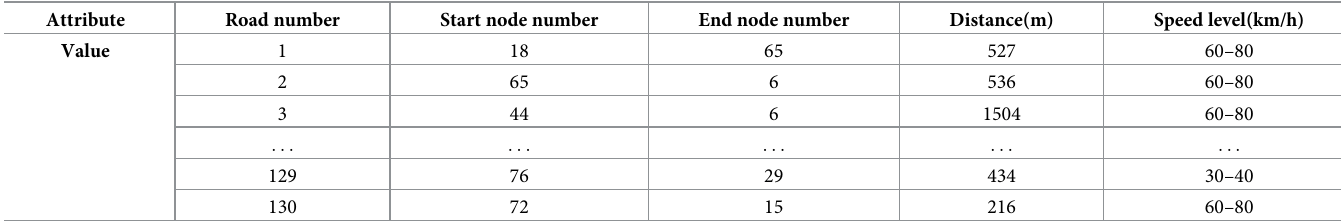
Table 5. Attributes of links of the road